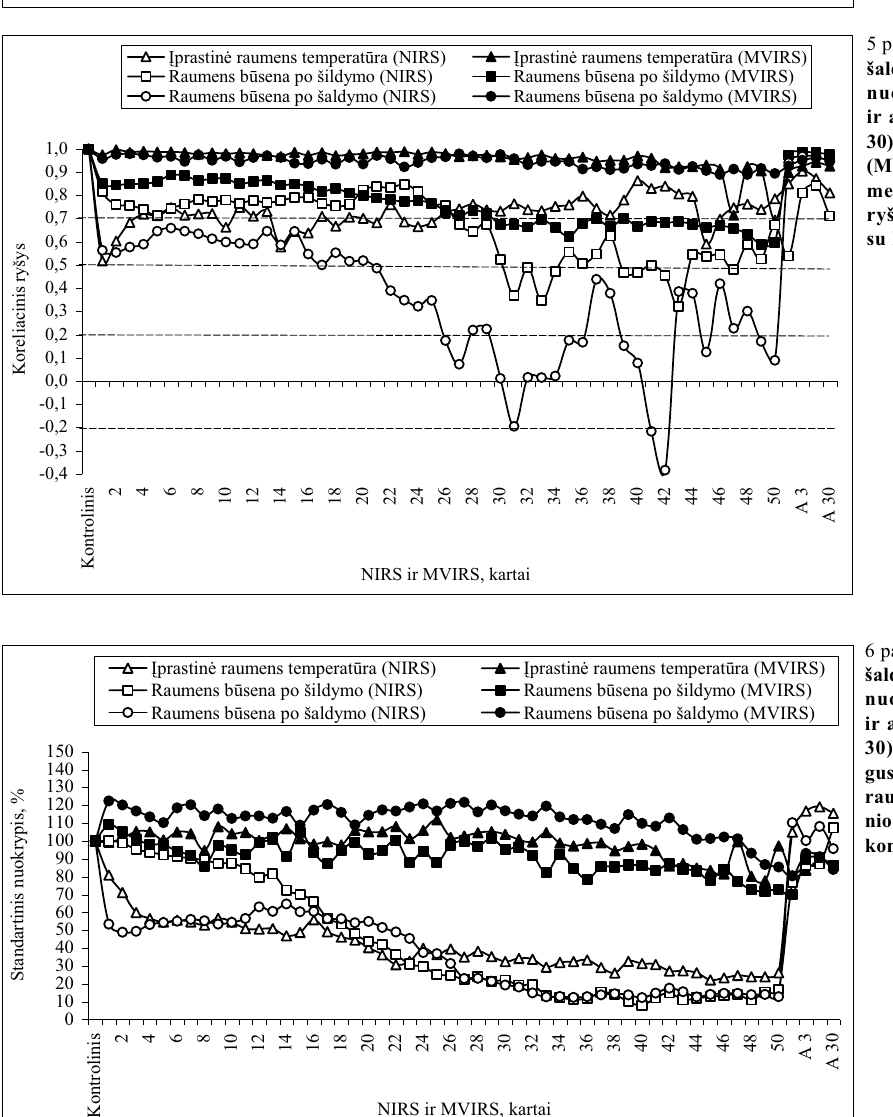
Pastaba. Išmatuota: raumens nuovargis krūvio (1—50-to susitraukimo) metu ir atsigavimas po krūvio praėjus 15 s (A 0,15), 3 (A 3), 8 (A 8) ir 30 (A 30) minučių. NIRS ir MVIRS jėga, esant tai pačiai rau- mens temperatūrai, reikšmingai skyrėsi: # — įprastinė raumens temperatūra (p < 0,01); * — raumens būsena po šildymo (p < 0,01); † — raumens būsena po šaldymo (p < 0,05); p — raumens izometrinio susitraukimo jėgos pokyčio priklausomybė nuo laiko ir temperatūros (MVIRS ar